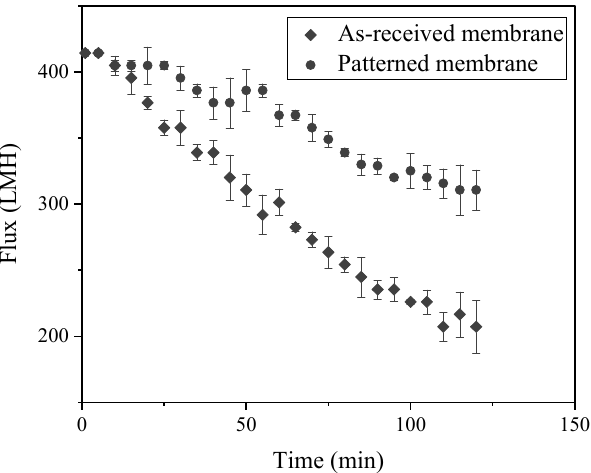
Figure 6. Bovine serum albumin (BSA) fouling tests. The initial flux was 414 ± 1 LMH for both samples. Error bars represent ± 1 ơ among three samples.